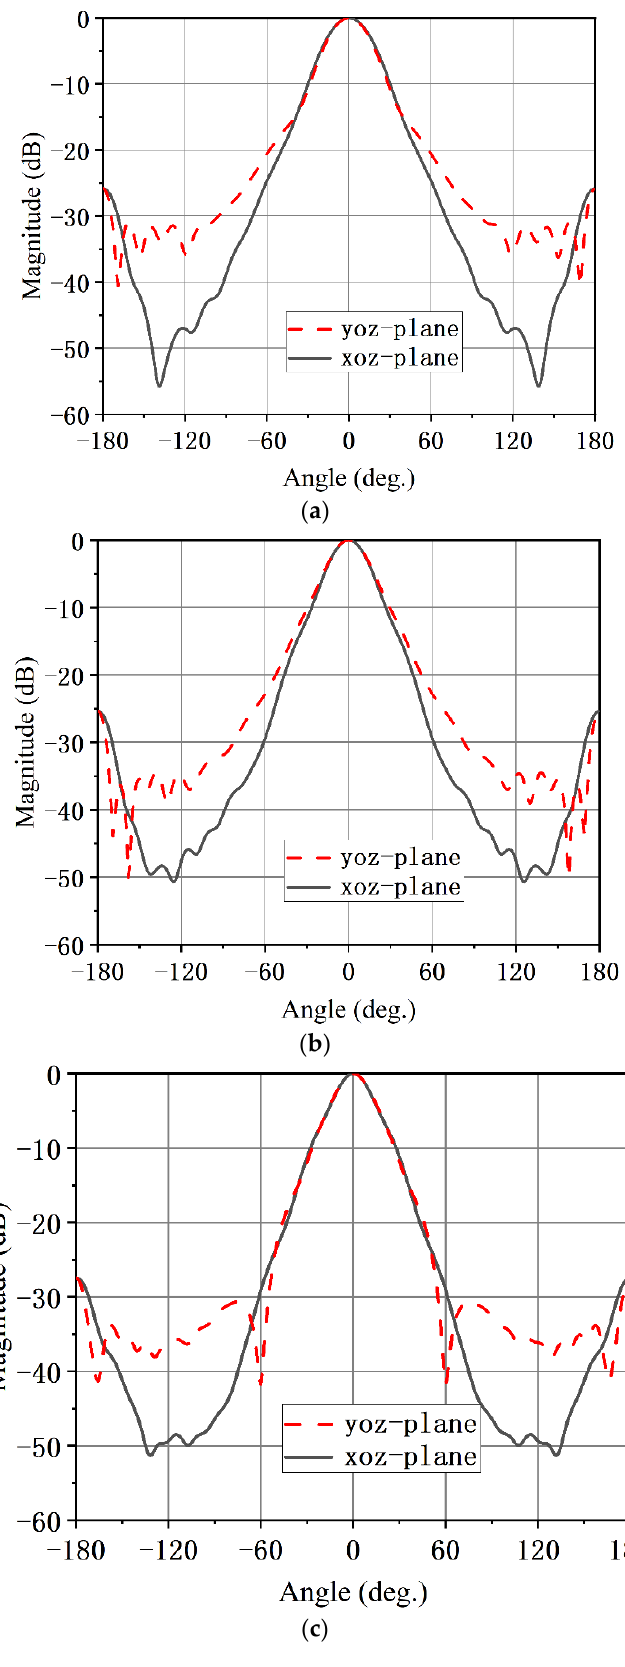
Figure 14. Simulated radiation patterns of the proposed conical corrugated horn antenna element at ( a ) 20 GHz, ( b ) 24 GHz and ( c ) 30 GHz.